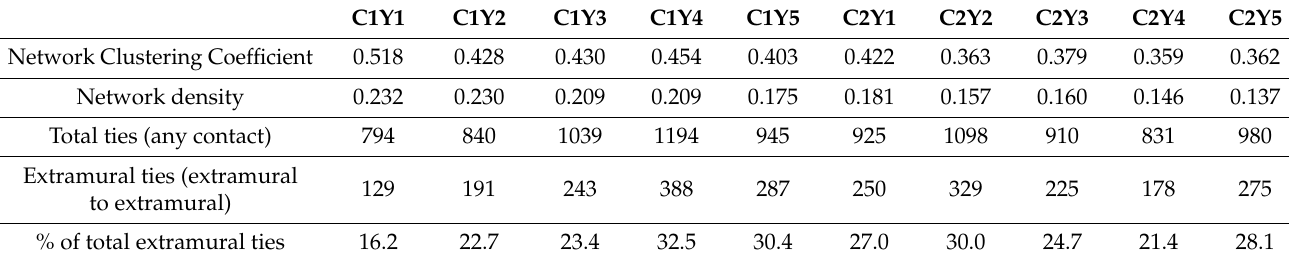
Table 5. Indicators of integration and collaboration of the NEC network over ten